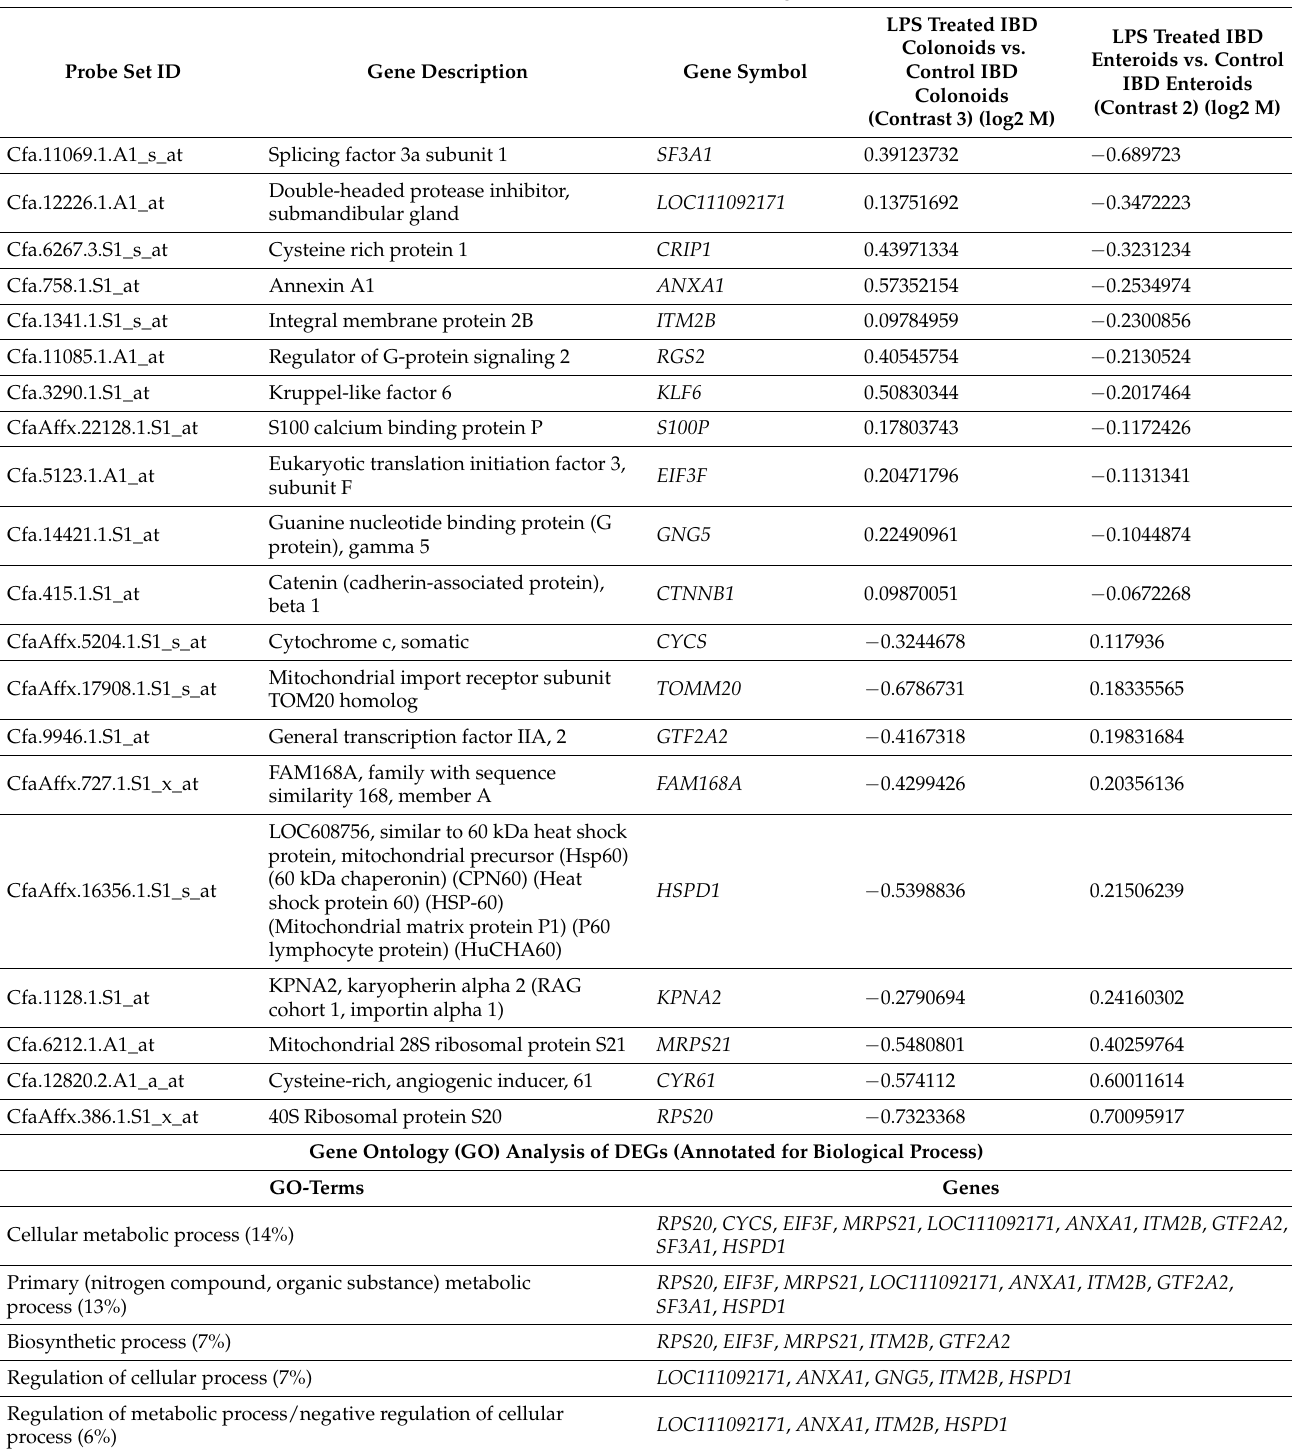
Table 13. The Gene Ontology (GO) analysis and the details about the 20 DEGs exhibiting an opposite trend (upregulated in IBD enteroids and downregulated in the IBD colonoids and vice versa) between the IBD enteroids and colonoids following LPS stimulation annotated for the biological process, molecular function, and cellular component categories. The percentages represent the number of genes in each functional